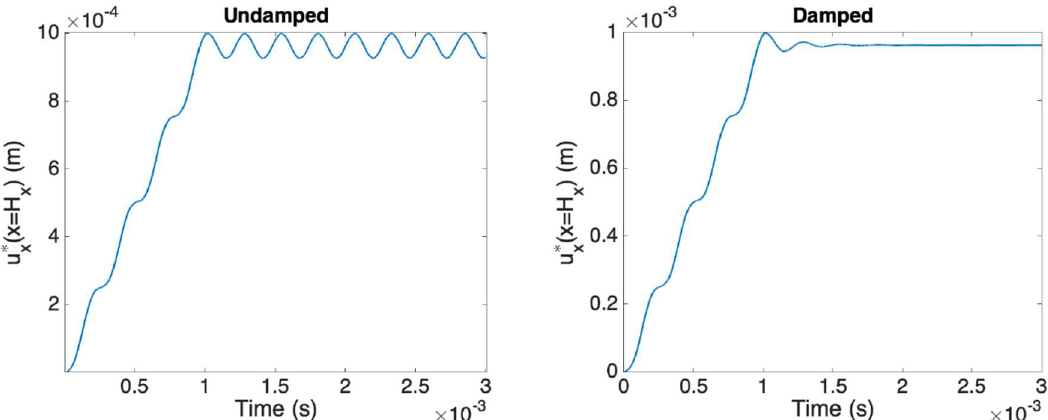
Fig. 10. Averaged displacement of the structure right surface: u ∗ x ( x = H x ) when using undamped and damped explicit integrations, left and right respectively.